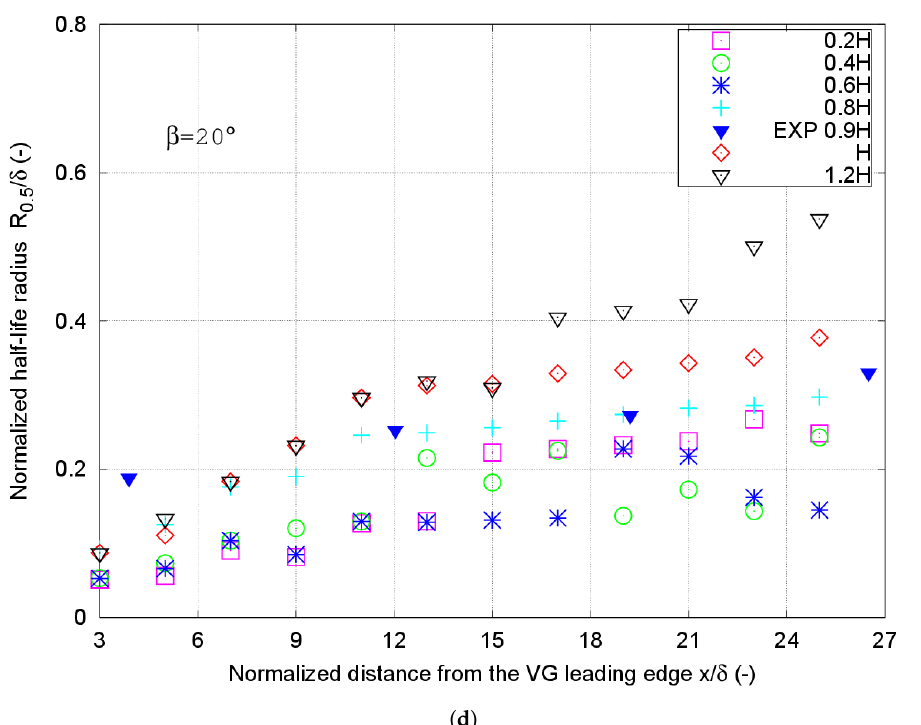
Figure 7. CFD results of the half-life radius R 0.5 for four different incident angles, ( a ) corresponds to β = 10 ◦ , ( b ) 15 ◦ , ( c ) 18 ◦ , and ( d ) 20 ◦ . EXP (blue triangles) indicates the experimental results obtained by Bray [34] for a VG height of 0.9H. Represented values are normalized with respect to the boundary layer thickness ( δ ) at the VG position. The y-axis represents the normalized half-life radius R 0.5 and the x-axis represents δ the normalized axial distance x δ